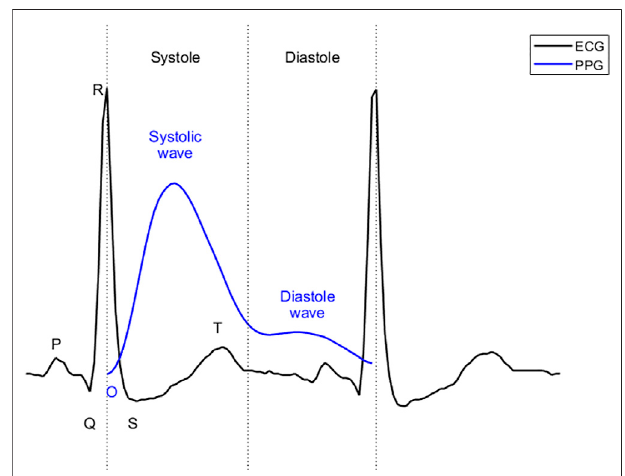
FIGURE 1 | Systole and diastole in ECG and PPG. The “ O ″ ” stands for the onset in